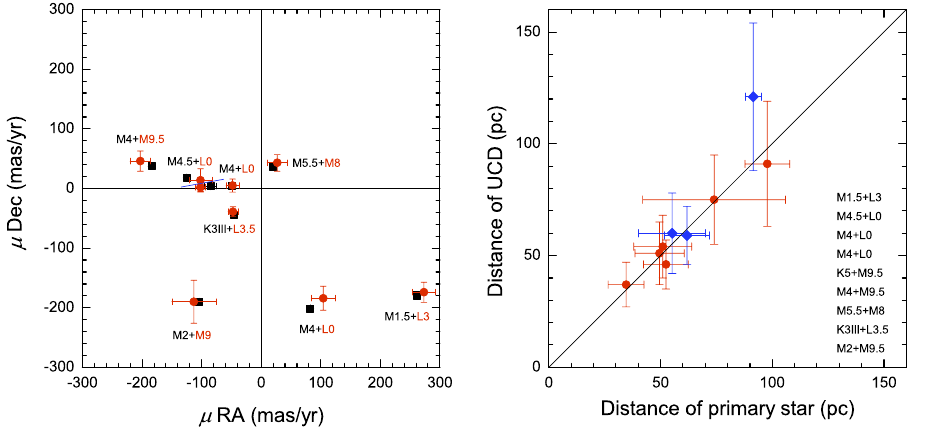
Figure 1. Left panel : PMs of nine binary systems. Spectral types of the primary stars ( black squares ) and UCDs ( red circles ) are labeled. A short line is used to separated two crowded binary systems. Right panel : Distances of UCDs and their primary star. Spectral type combinations are listed in according distance of primaries in the bottom right of the plot. The red squares and blue diamonds indicate the objects with and without SDSS spectra